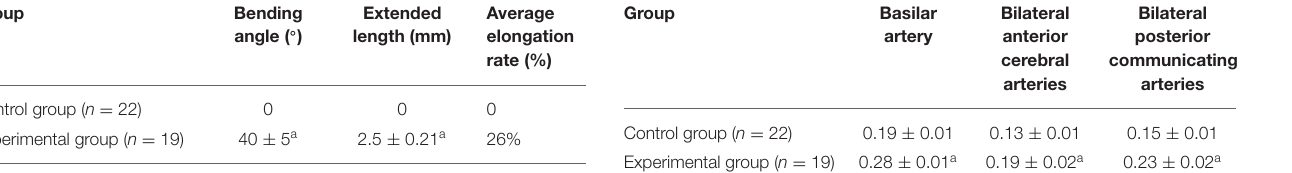
TABLE 2 | Changes in curvature, actual length, and elongation rate of the basilar artery after modeling. Group Bending Control group ( n = 22) 0 0 0 Experimental group ( n = 19) 40 ± 5 a 2.5 ± 0.21 a 26% Compared with the control group. a P < 0.01.